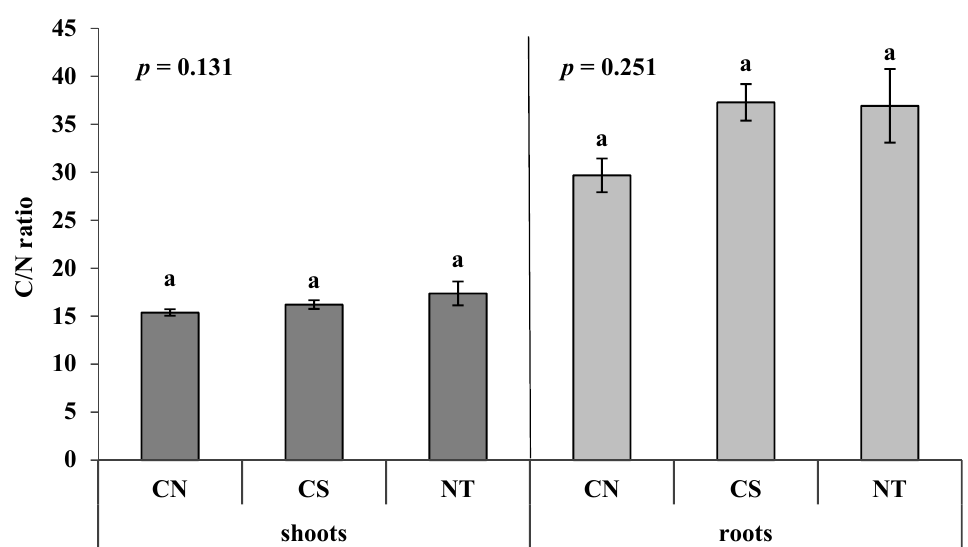
Figure 6. Soybean shoot and root C/N ratios according to the different tillage systems (CN, conventional; CS, conservation; NT, no-tillage). Data are the means ± standard error. Letters (a) indicate nonsignificant differences ( p ≤ 0.05, Tukey’s tests) among treatments.